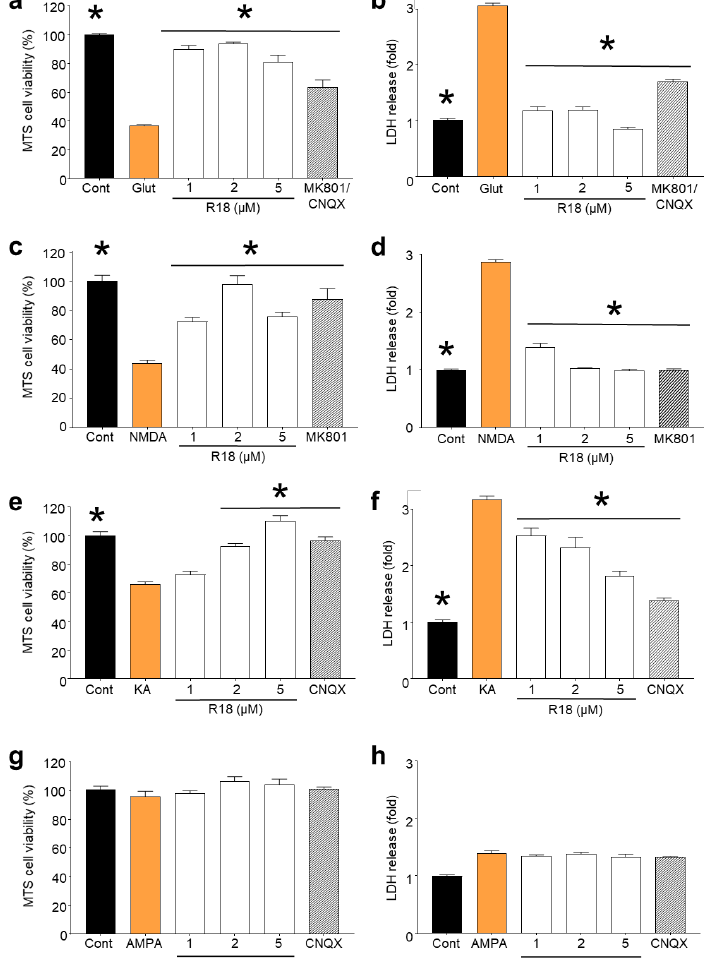
Figure 2. R18 protects primary cortical neurons against excitotoxicity induced by various ionotropic glutamate receptor agonists. Neuronal cultures were pre-treated with R18 (1, 2, and 5 µ M) for 10 min and exposed to a 100 µ M final concentration of specific iGluR agonists for 5 min. The medium was then replaced, and neuronal viability and death were measured at 24 h post-insult via MTS and LDH assays, respectively. Receptor agonists included ( a , b ) glutamate, ( c , d ) NMDA, ( e , f ) kainic acid, and ( g , h ) AMPA. The receptor antagonists, MK801 (10 µ M) and CNQX (10 µ M), were used as positive controls. Absorbance values were adjusted to represent cell viability (untreated control as 100%). Values are means ± SEM; n = 3, with a minimum of eight biological replicates per sample in each experiment; * p < 0.05. Experiments were conducted at least three times with independent neuronal